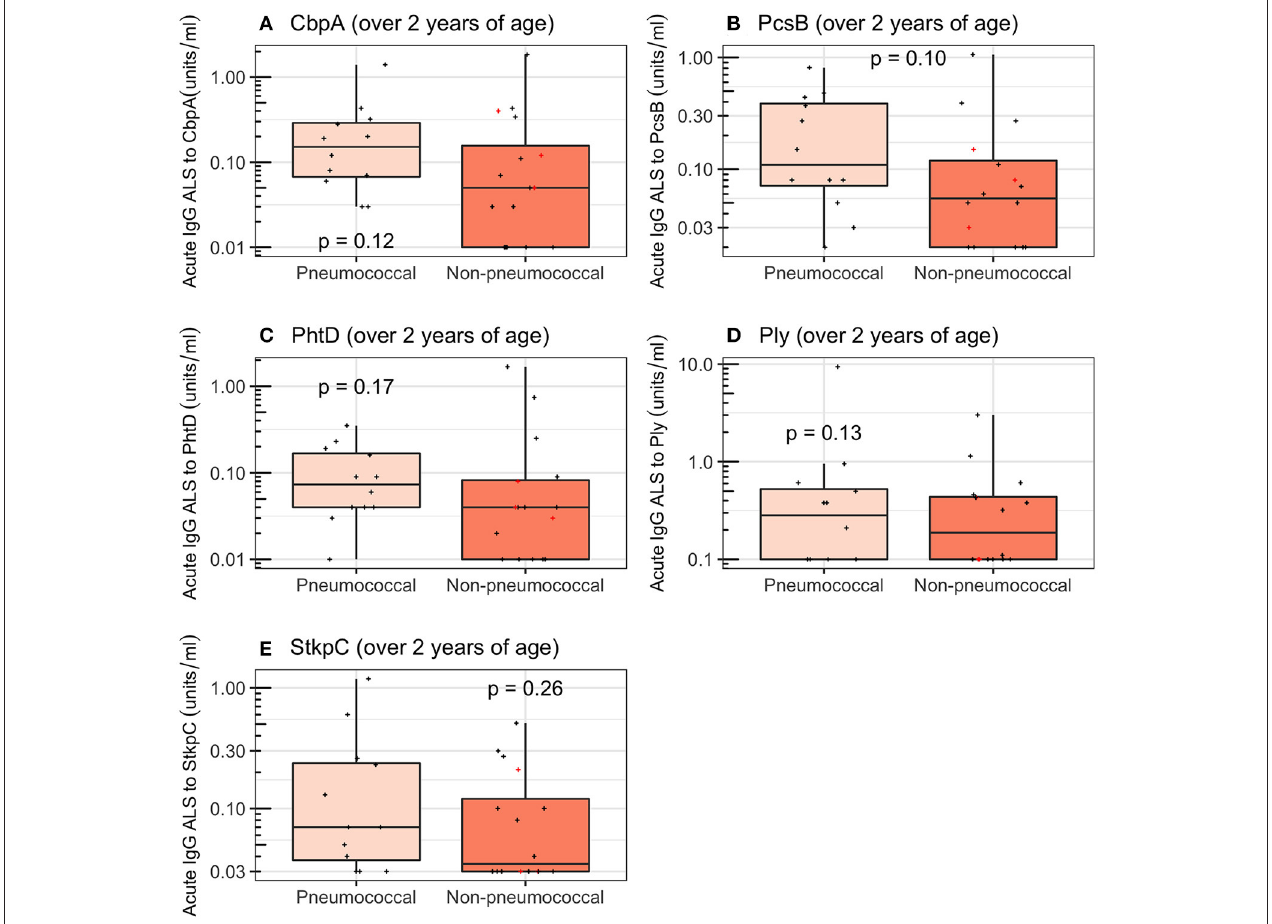
FIGURE 6 | Acute IgG ALS to pneumococcal proteins in children with pneumococcal pneumonia and non-pneumococcal pneumonia ≥ 2 years of age enrolled into the study. Red crosses represent children with definite other bacterial pneumonia (two children with Staphylococcus aureus , and one child with Pseudomonas spp. isolated from blood). Dashed horizontal lines represent thresholds derived from the Youden Index, p -values were derived from the Wilcoxon rank sum test. (A) Choline binding protein A (CbpA); (B) protein for cell wall separation of group B streptococci (PcsB); (C) pneumococcal histidine triad D (PhtD); (D) pneumolysin (Ply); (E) serine threonine kinase protein C